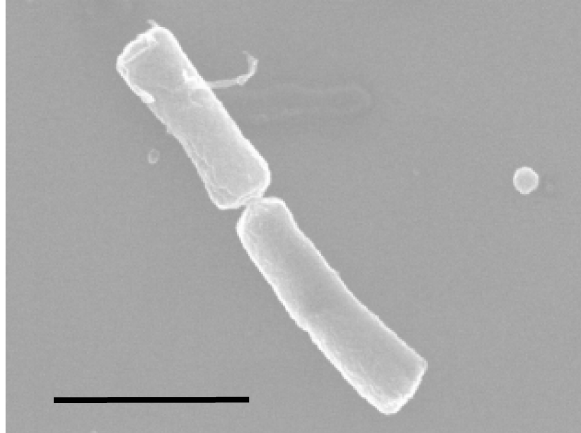
Figure 1. Scanning electron micrograph of isolate VA1 in pairs. Bar = 1